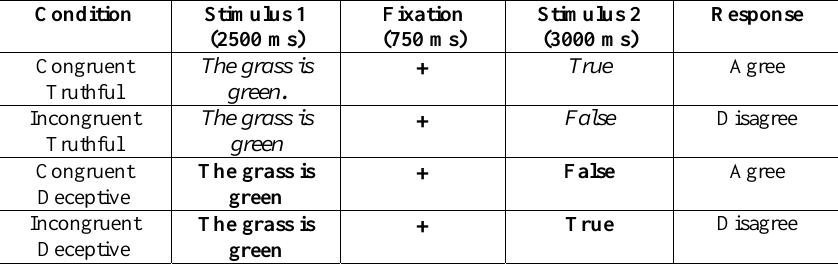
Fig. 4. Time course of stimulus administration for the two-stimulus paradigm in Experiment